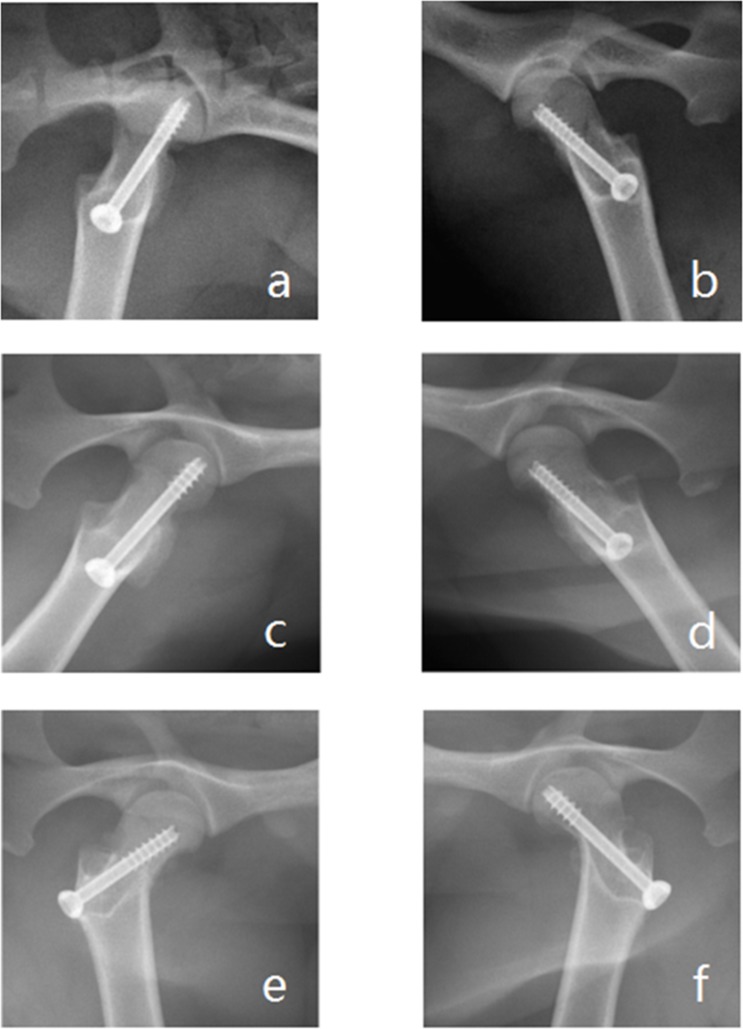
X-ray examination.After surgery (day 1), the fractures in both the experimental group (a) and control group (b) were clear and received good reduction. By 8 weeks postoperatively, the fracture line disappeared in the experimental groups (c), and BMD in the fracture site was similar with surrounding bone tissue. In the control group (d), the fracture line was blurred and BMD was lower than the bone tissue around the fracture site. At 12 weeks after surgery, the fracture lines in both groups disappeared. The BMD of the fracture site in the experimental group (e) was consistent with the surrounding bone tissue; however, the BMD in the control group (f) was still lower than the neighboring bone tissue.